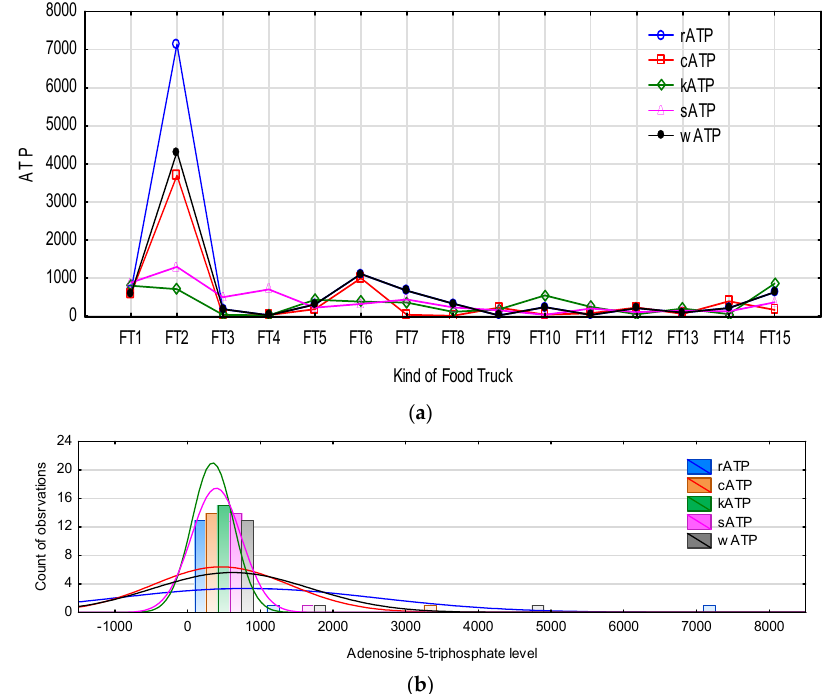
Figure 4. Level of adenosine 5-triphosphate on surfaces in food truck outlets, frequency and range of ATP results on analysed surfaces: r—refrigerator; c—cutting board; k—knife; s—serving board; w—working board. ( a ) Level of ATP on surfaces in food trucks outlet. ( b ) The frequency and range of ATP results on the analysed surfaces.